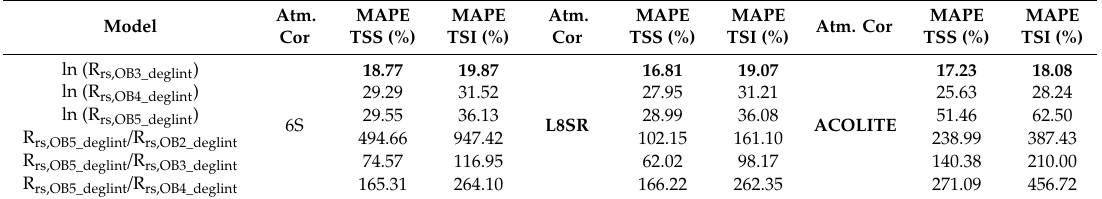
Table 4. The MAPE values (%) for empirical models applied to OLI atmosphere-corrected scenes after glint correction (6S, L8SR, and ACOLITE). The R² and RMSE are in the Supplementary Files C. The bold values in each column refer to the best MAPE values (n = 16).